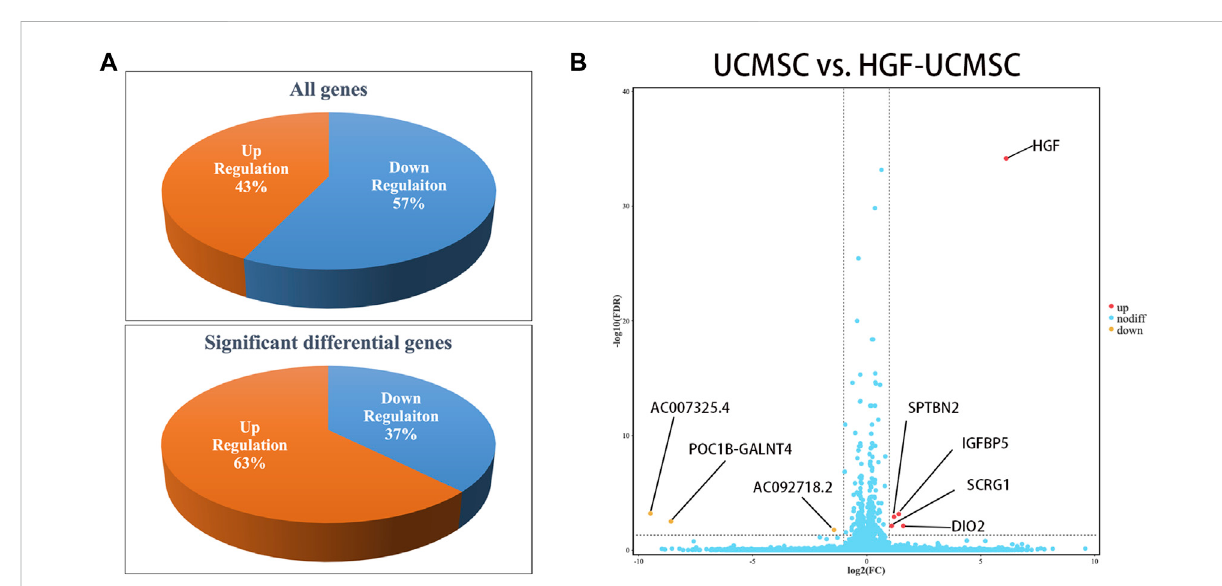
FIGURE 6 Analysis of transcriptional expression of UCMSCs and HGF- UCMSCs. (A) The percentage of up-regulated and down-regulated genes was calculated among all genes (upper panel) or the signi fi cant differential genes (lower panel) (B) Signi fi cant differential gene symbols are shown in the volcanic